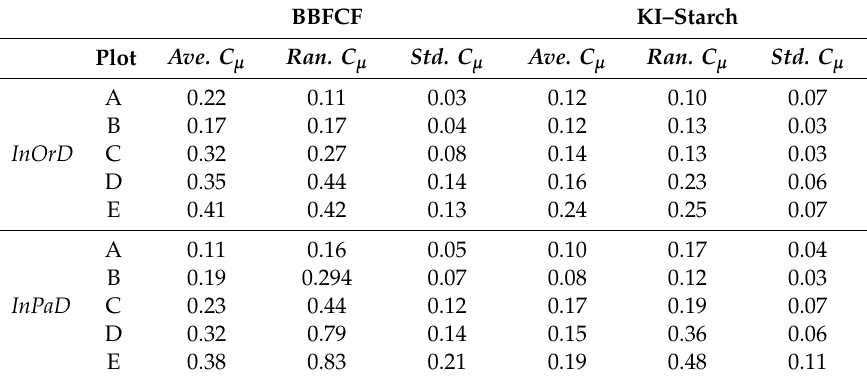
Table 3. Statistical characteristic values of the non–uniformity coefficient ( C µ )–distance curve in the orthogonal and parallel directions to the stained section.